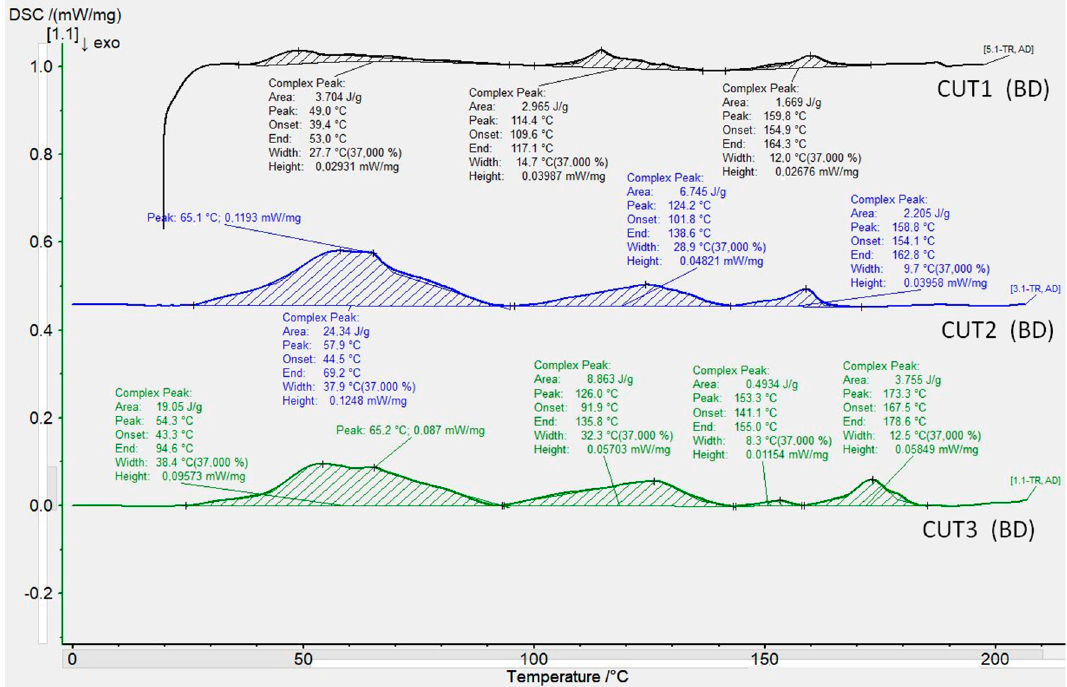
Figure 6. DSC thermograms obtained for CUT foil samples.